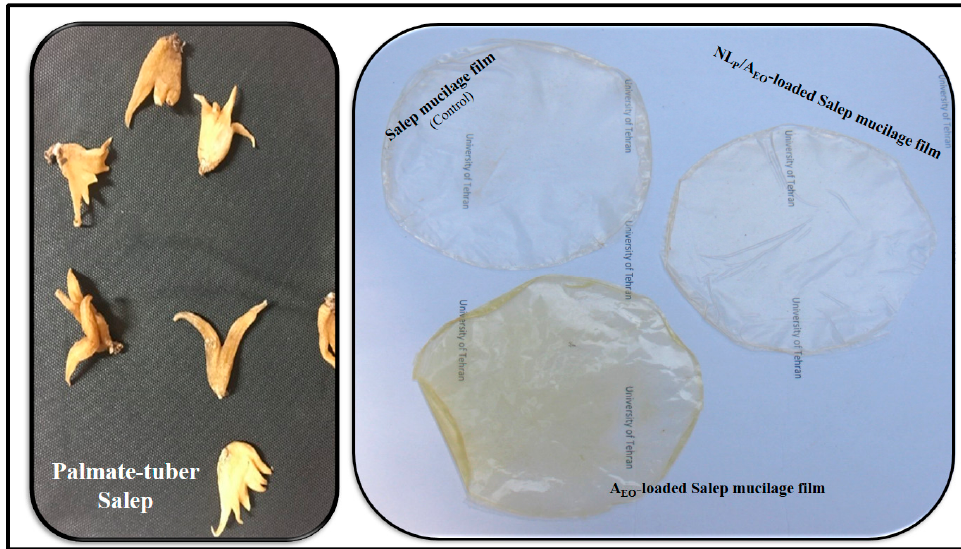
Figure 1. Photographic images of the palmate-tubers Salep and Salep mucilage control/antibacterial bionanocomposite films.